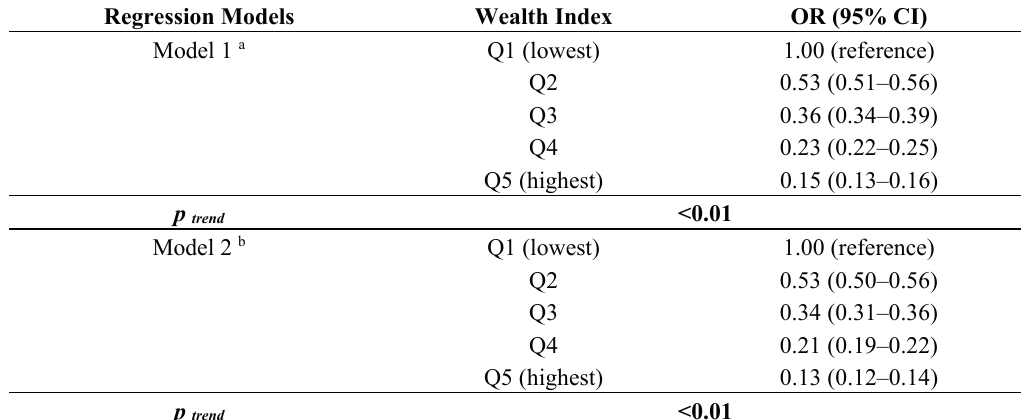
Table 6. Associations of wealth index and mental disability among the Chinese